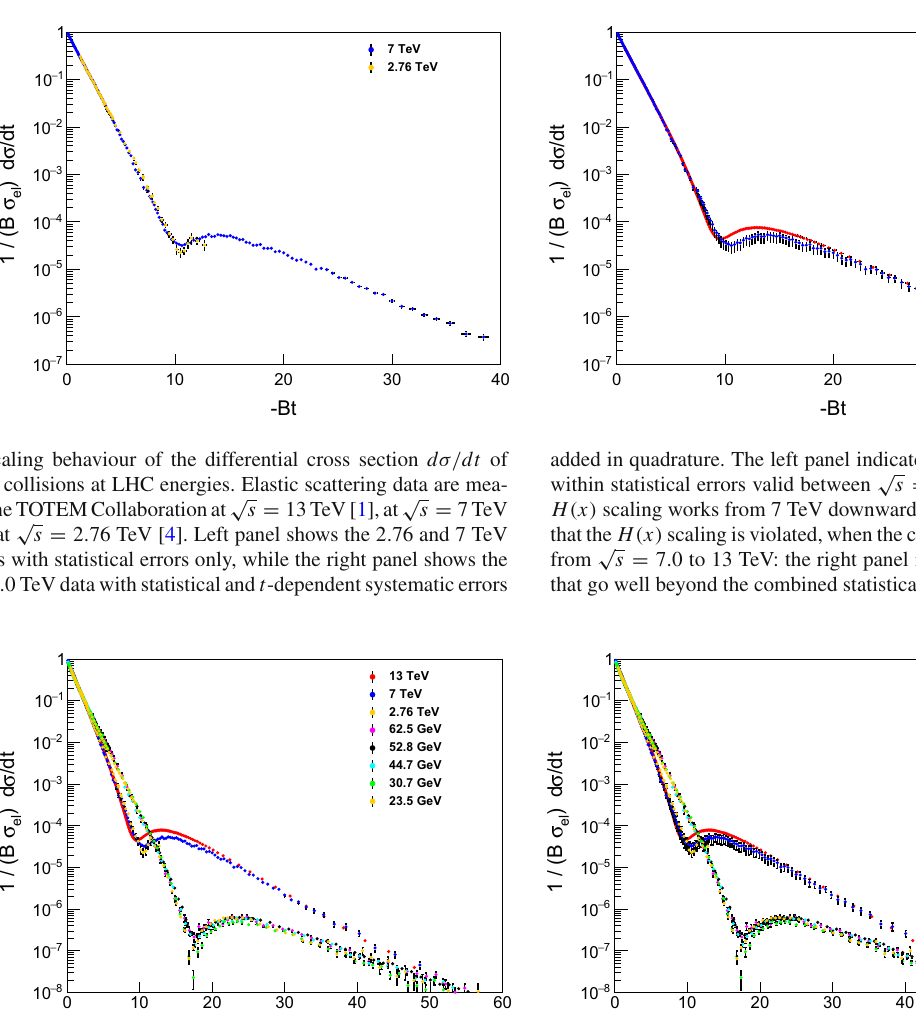
of the p ¯ p collisions measured by the D0 collaboration at √ s = 1 . 96 TeV Tevatron energy [8]. The right panel of Fig.